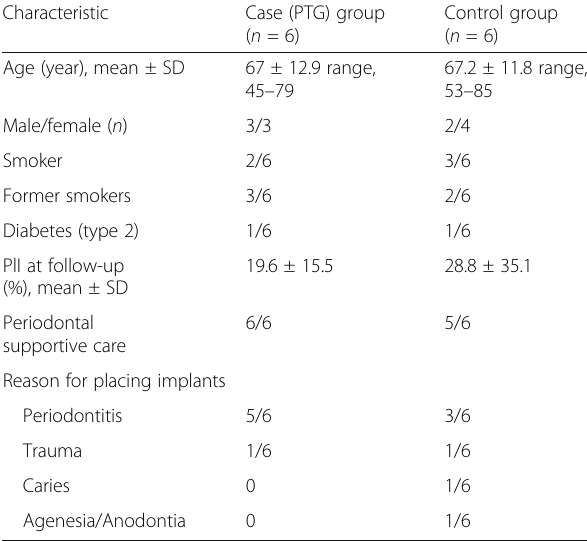
Table 1 Characteristics of the subjects at the 7-year follow-up Characteristic